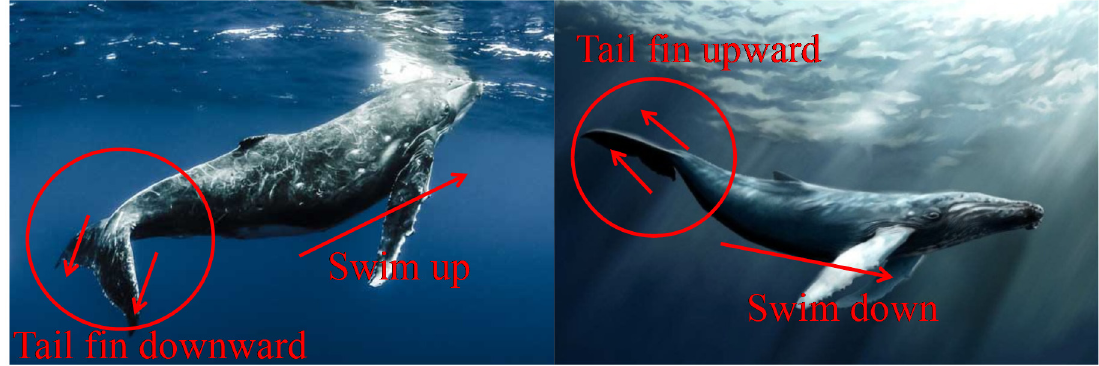
Figure 1. Whale swimming and tail fin flapping.